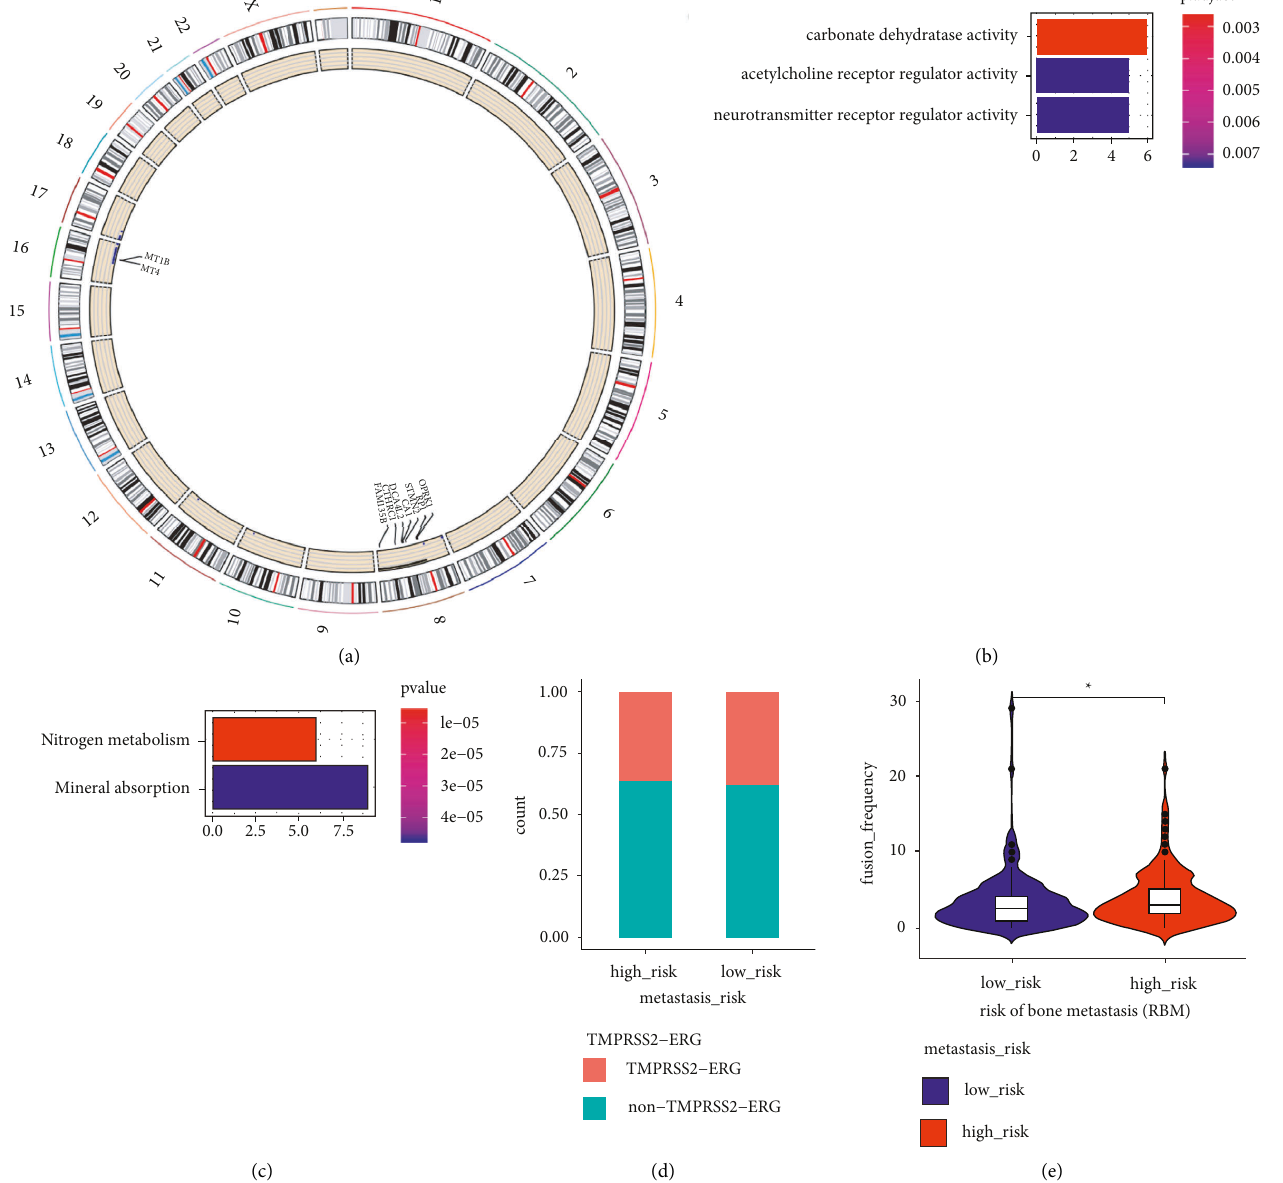
Figure 3: Comparisons of CNV and gene fusion frequencies in the HRBM and LRBM cohorts. (a) CNVs with different mutational frequencies in the LRBM and HRBM patient cohorts, with the inner circle presenting a scatter plot of the 676 CNVs that were differentially frequent in these two cohorts, and the outer circle corresponding to the locations of these genes on specific chromosomes. Those genes harboring CNVs that were also significantly differentially expressed between these two cohorts are marked within the circle. (b-c) GO (b) and KEGG (c) analyses of genes containing CNVs at different frequencies in the LRBM and HRBM cohorts, with enriched terms being shown on the left and bar plots on the right corresponding to the number of genes associated with the indicated term. Bar coloration is based on the P value for the corresponding term. (d) Frequencies of TMPRSS2-ERG gene fusions in the LRBM and HRBM cohorts, with the y -axis corresponding to the TMPRSS2-ERG gene fusion proportion. (e) Frequencies of gene fusions in the LRBM and HRBM cohorts. Violin plots show gene fusion frequencies in individual samples as dots, with boxplots being drawn within violin plots. ∗ P < 0 . 05, ∗∗ P < 0 . 01, ∗∗∗ P < 0 . 001; two-sided Mann–Whitney U